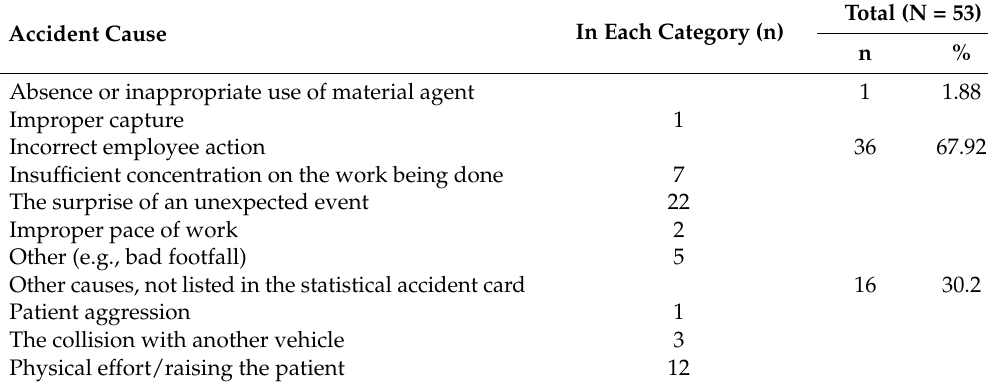
Table 4. Causes of accidents at work among paramedics,